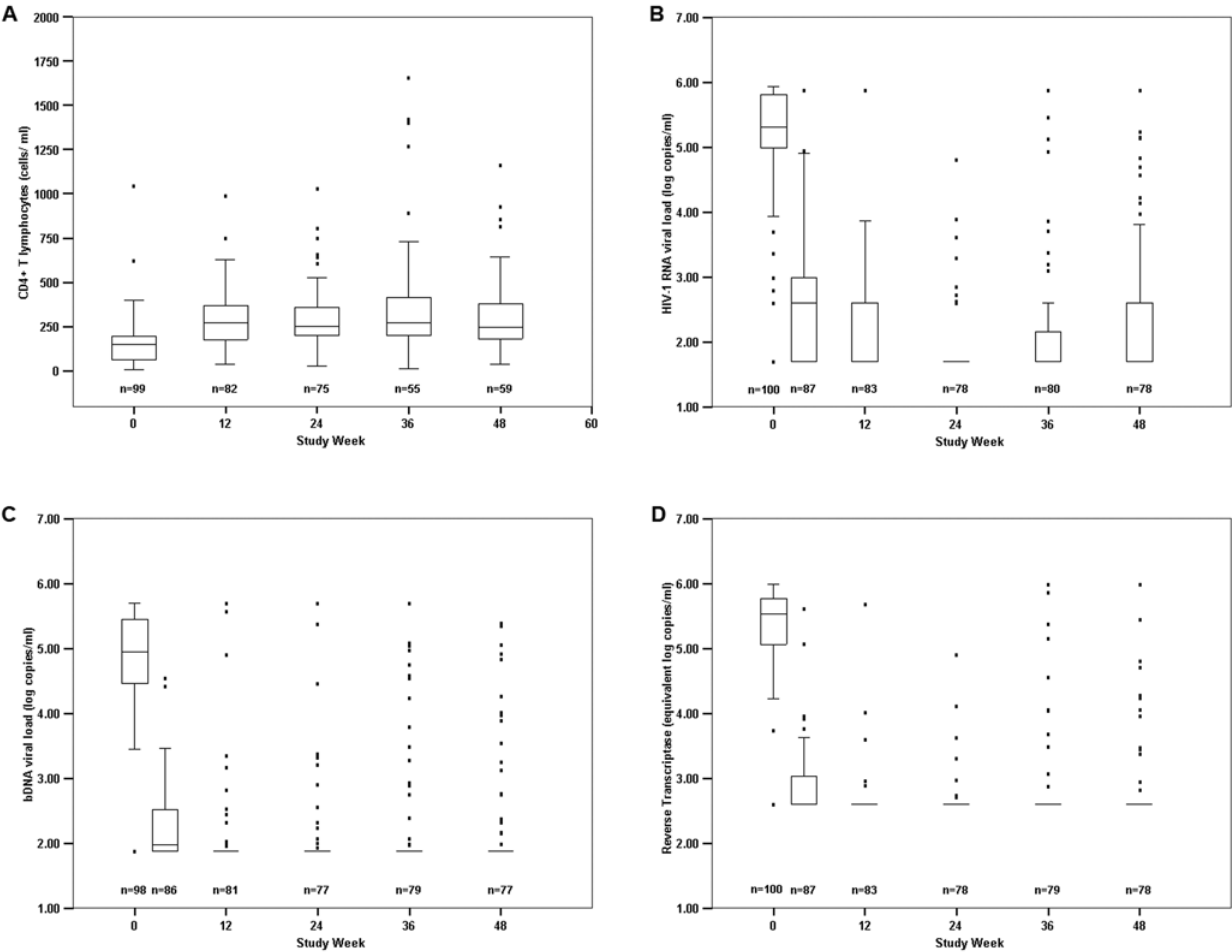
Figure 4. The distribution of CD4 cell count and HIV viral loads since initiation of antiretroviral therapy (study week 0). A. Distribution of CD4 cell count; B. HIV viral load by RNA PCR; C. HIV viral load by branched DNA (bDNA) assay; D. HIV viral load by Cavidi reverse transcriptase (RT) assay. Top and bottom of the boxes are 25th and 75th percentiles, respectively. Horizontal lines within the boxes indicate median values. Central vertical lines (whiskers) that extend from the boxes to the highest and lowest rates indicate the 95% and 5%, respectively. Dots indicate the individual values outside whiskers.